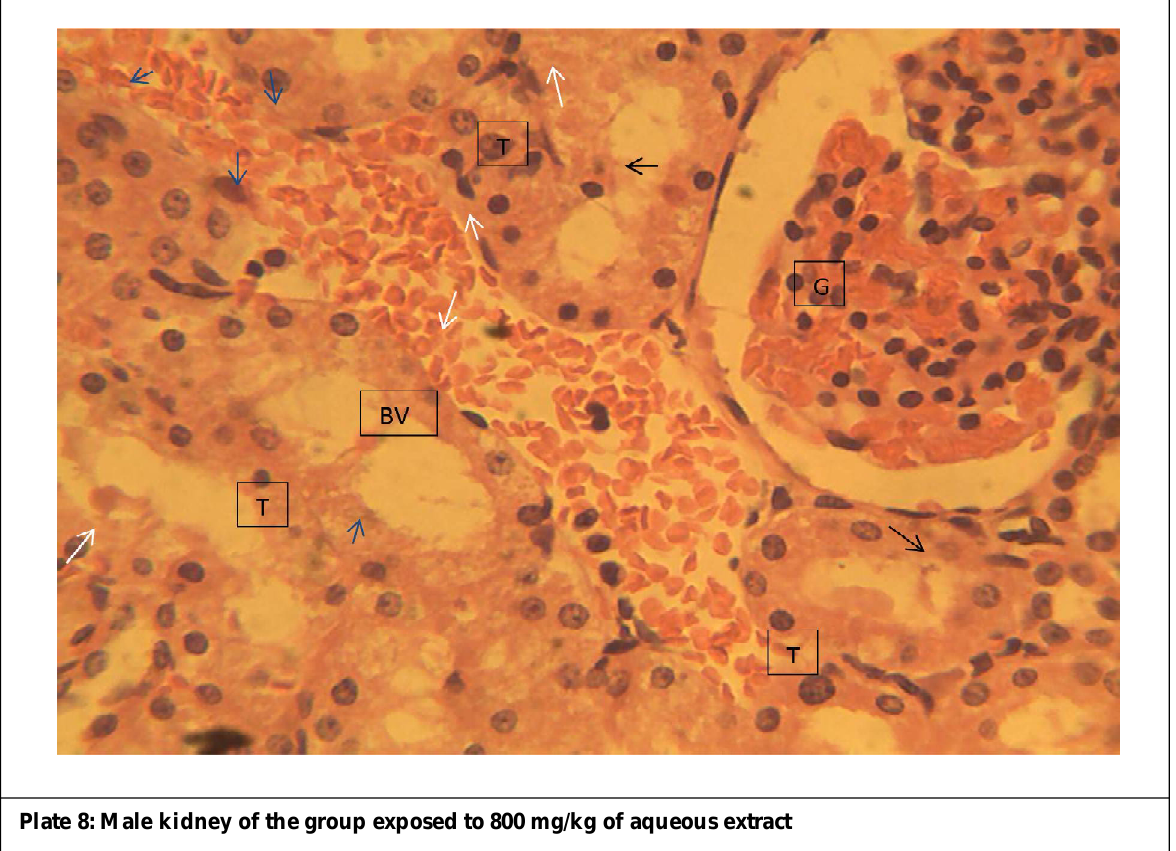
Plate 8: Male kidney of the group exposed to 800 mg/kg of aqueous extract